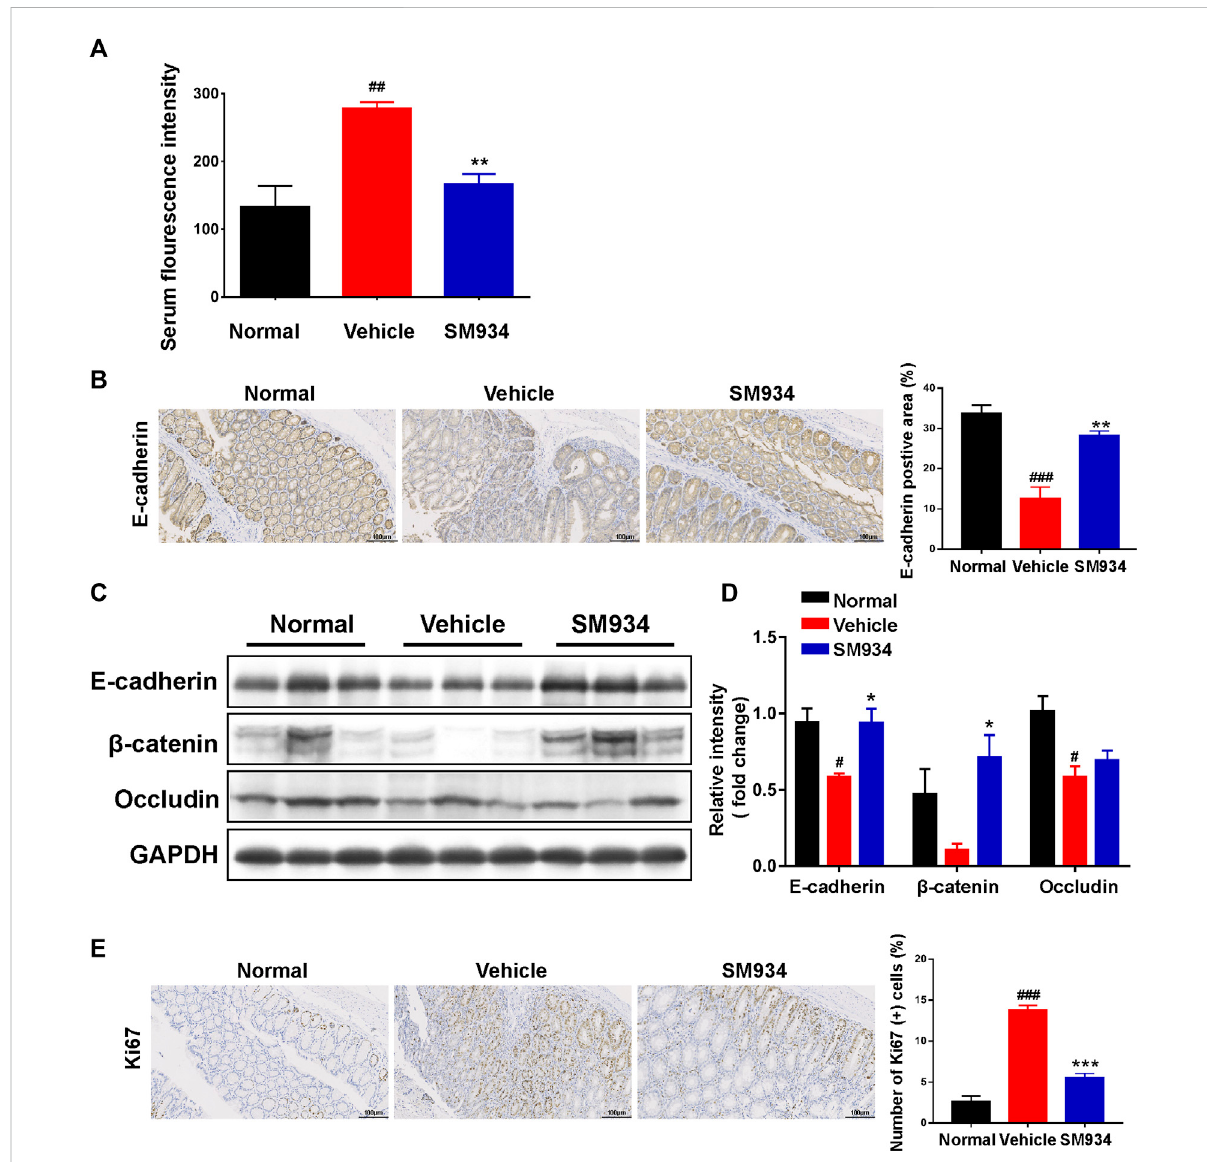
SM934 restored the intestinal barrier and reduced abnormal epithelial proliferation in TNBS-induced colitis mice. (A) Serum FITC-dextran fl uorescence intensity was used to observe the intestinal permeability ( n = 4). (B) Representative images of the positive staining area of E-cadherin with immunohistochemical staining (scare bar, 100 µm), right; the positive area was analyzed (left). (C) Western blotting assayed the expressions of E-cadherin/ β -catenin/occludin in colon tissue. (D) Relative intensity of protein to GAPDH. Data are shown as means ± SEM ( n = 3). (E) Representative images of colon sections stained with the proliferation marker Ki67 (Scale bar, 100 µm), right; the number of Ki67-positive cells was counted, left. # p < 0.05; ### p < 0.001 vs . normal group; * p < 0.05, ** p < 0.01, and *** p < 0.001 vs . vehicle